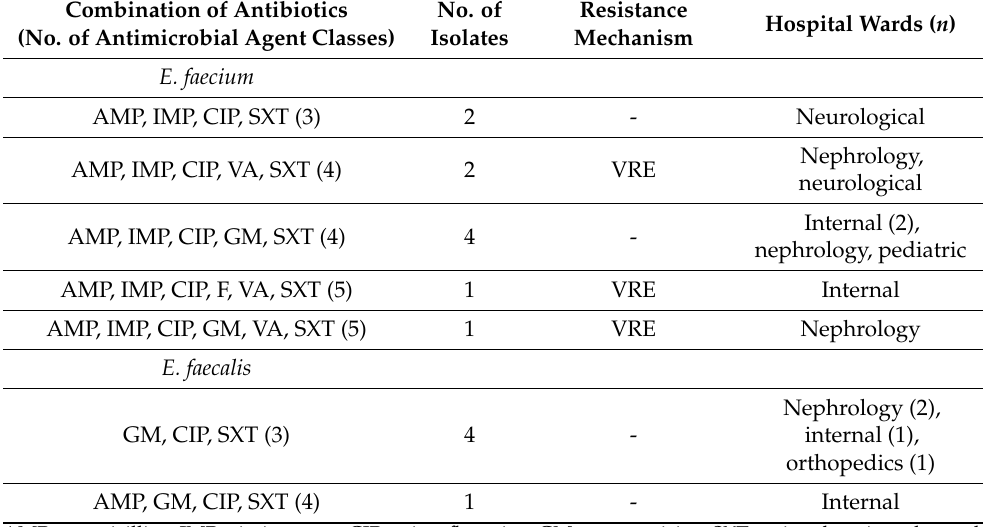
Table 10. Multi-drug resistance pattern of Gram-positive bacteria isolated from urine culture of hospitalized patients from January to June